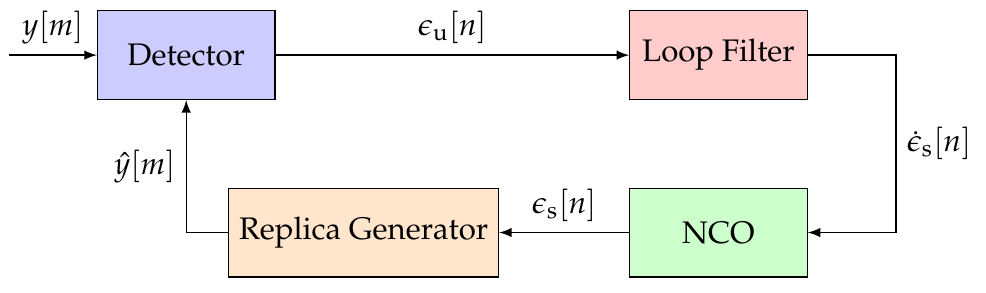
Figure 1. Architecture of a conventional scalar tracking loop (STL). ©IEEE. Adapted, with permission, from